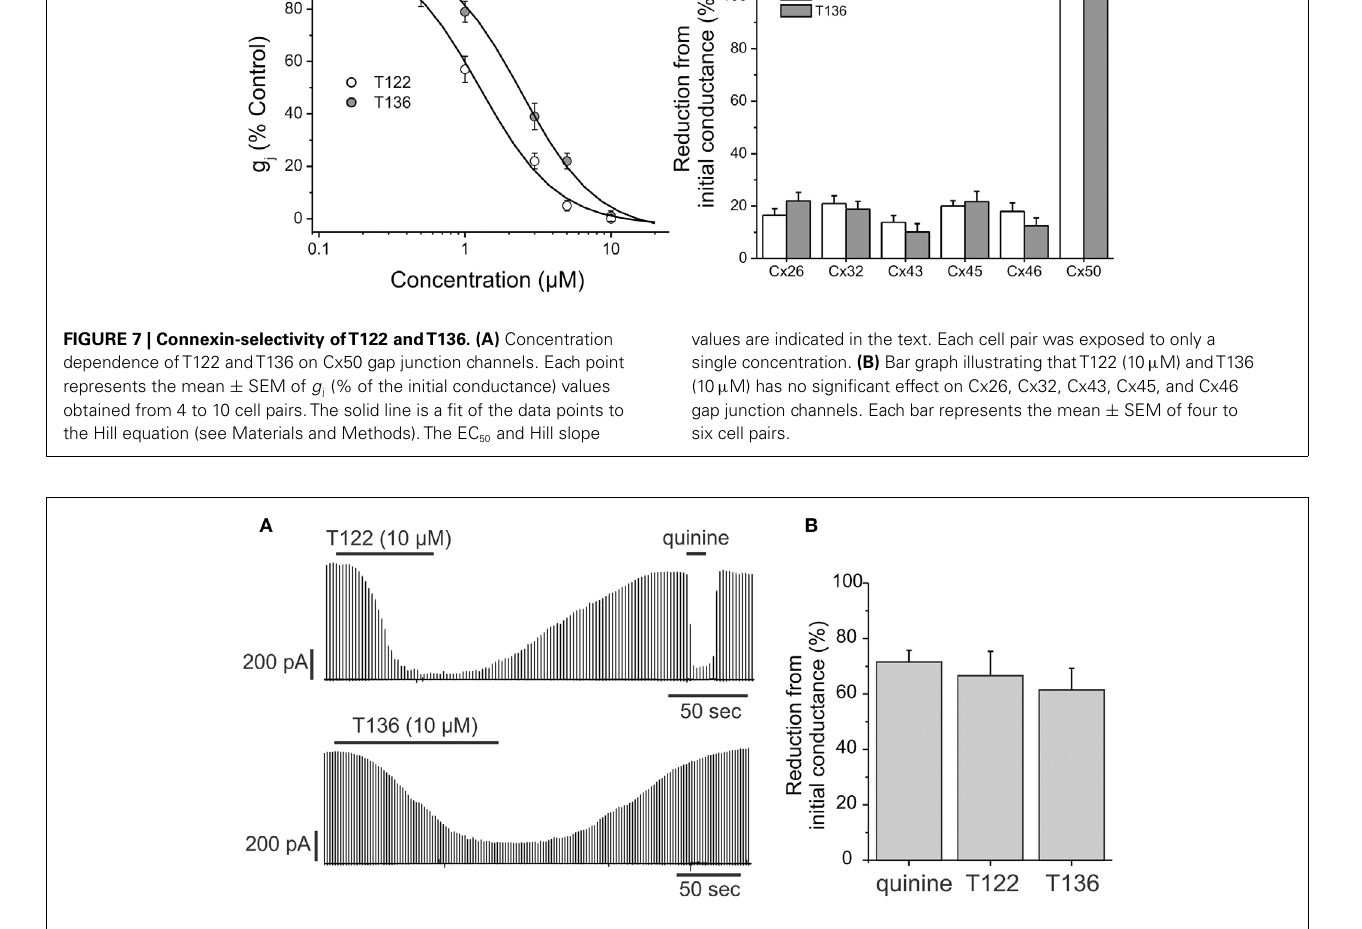
recordings inT122 andT136 are from two different cell pairs. (B) Bar graph summarizing the effect ofT122 (10 μ M) andT136 (10 μ M), compared to that of quinine on coupling in epithelial cells. Each bar represents the mean ± SEM of four to six cell